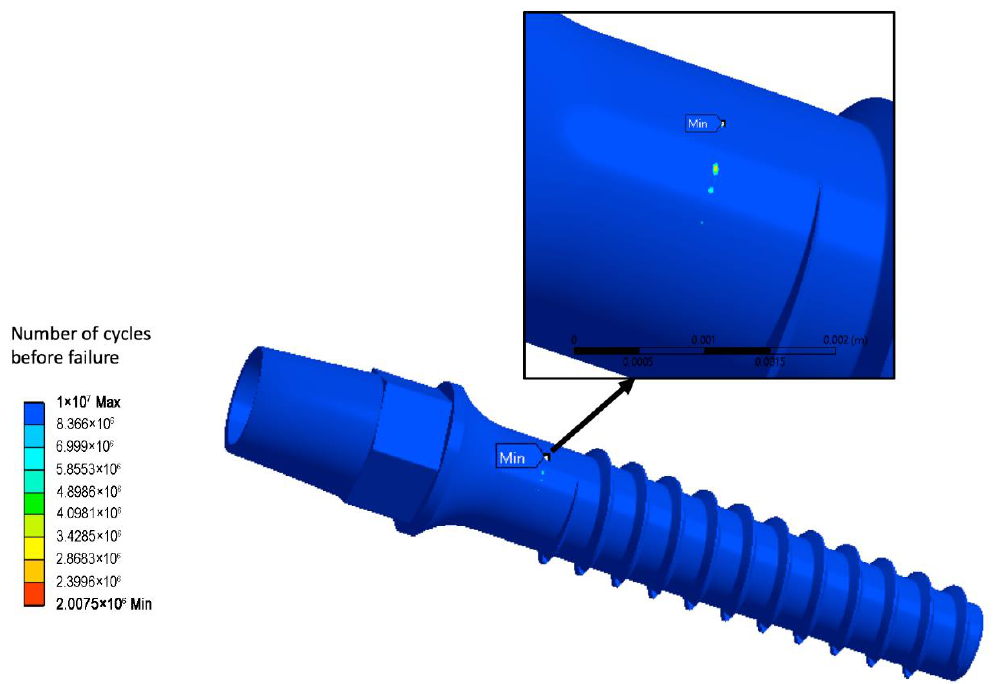
Figure 6. Life prediction for the CG Ti implant with a standard geometry.